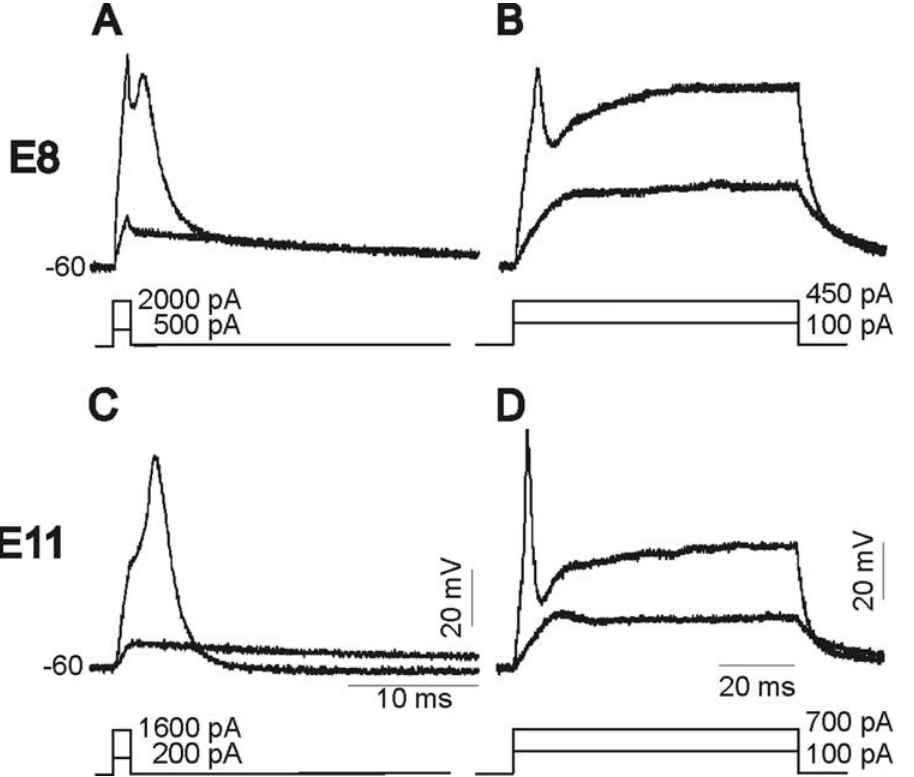
Figure 9. Typical action potentials generated in E8 and E11 chicken spinal motoneurons infected with RCASBP(B). Motoneurons were obtained from chicken embryos isolated at E8 or E11. Individual action potentials were generated by injection of 1 ms-depolarizing currents ( A & C ). Injection of long depolarizing current pulses (50 ms, B & D ) only generated one action potential. Bottom trace in A – D represents the stimulation protocol used and the amount of current injected.